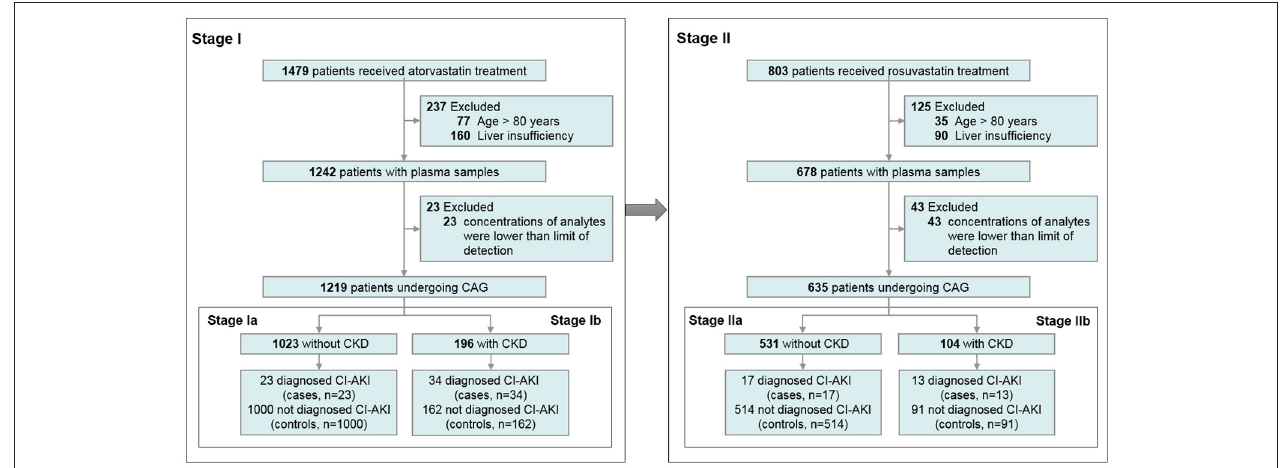
FIGURE 1 | Flow chart of the enrolment of the participants. CAG, coronary angiography; CI-AKI, contrast-induced acute kidney injury; CKD, chronic kidney disease.